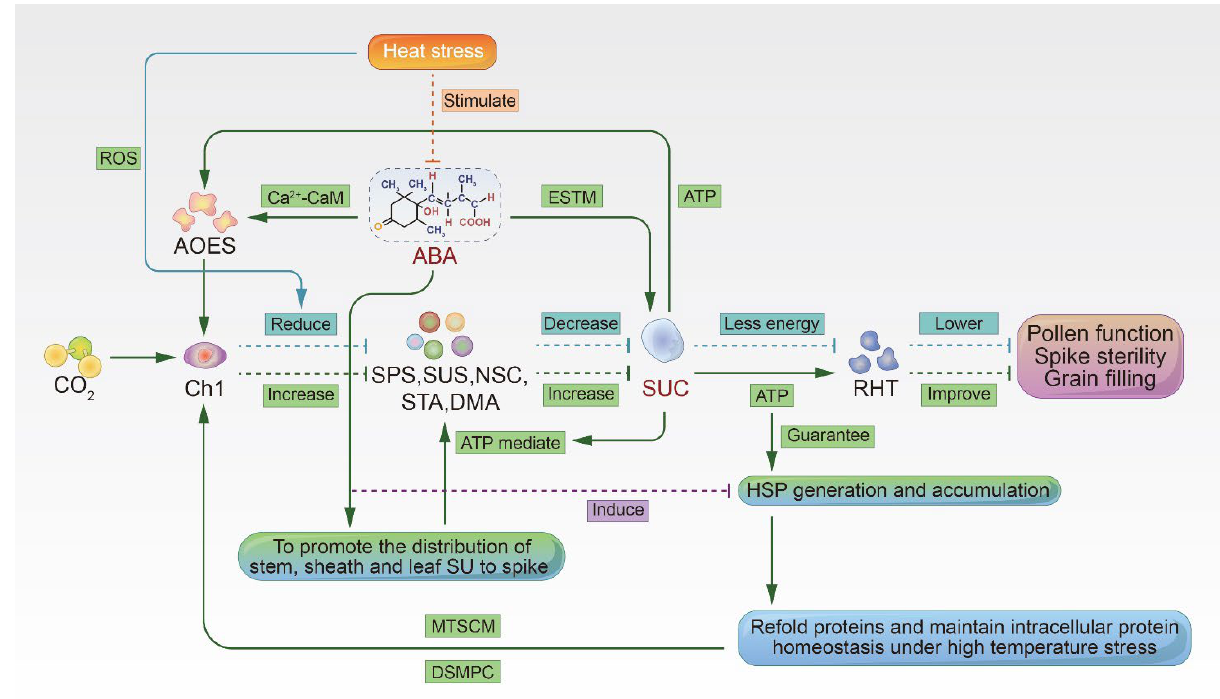
Figure 2. Mind map showing how ABA regulates sugar metabolism and improves heat tolerance in plants. AOES, antioxidant defense; ATP, adenosine triphosphate; Chl, chloroplast; DM, dry matter; DMA, dry-matter accumulation; DSMPC, delayed senescence and maintenance of photosynthetic capacity; ESTM, enhanced sucrose transport and metabolism; HSPs , heat-shock proteins; MTSCM, maintaining the thermal stability of the cell membrane; NSC, nonstructural carbohydrate; RHT, resist high temperature; ROS, reactive oxygen species; SPS, sucrose phosphate synthase; STA, starch content; SU, sucrose; SUC, sucrose content; SUS, sucrose synthase.